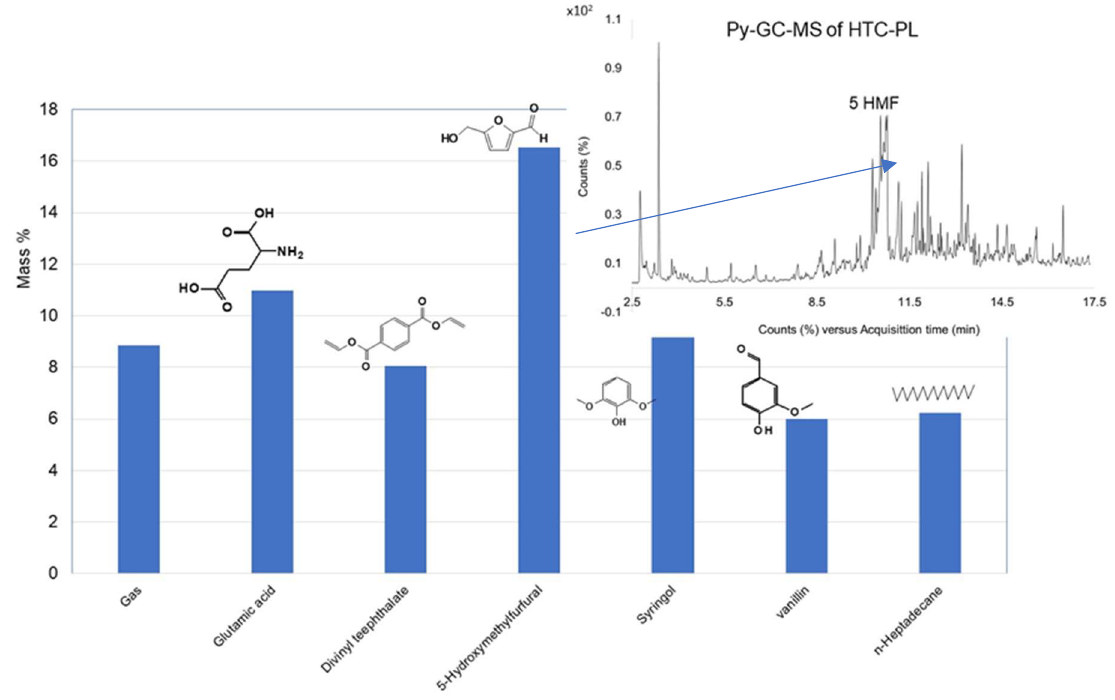
Figure 2. Selectivity of major compounds in HTC-PL.